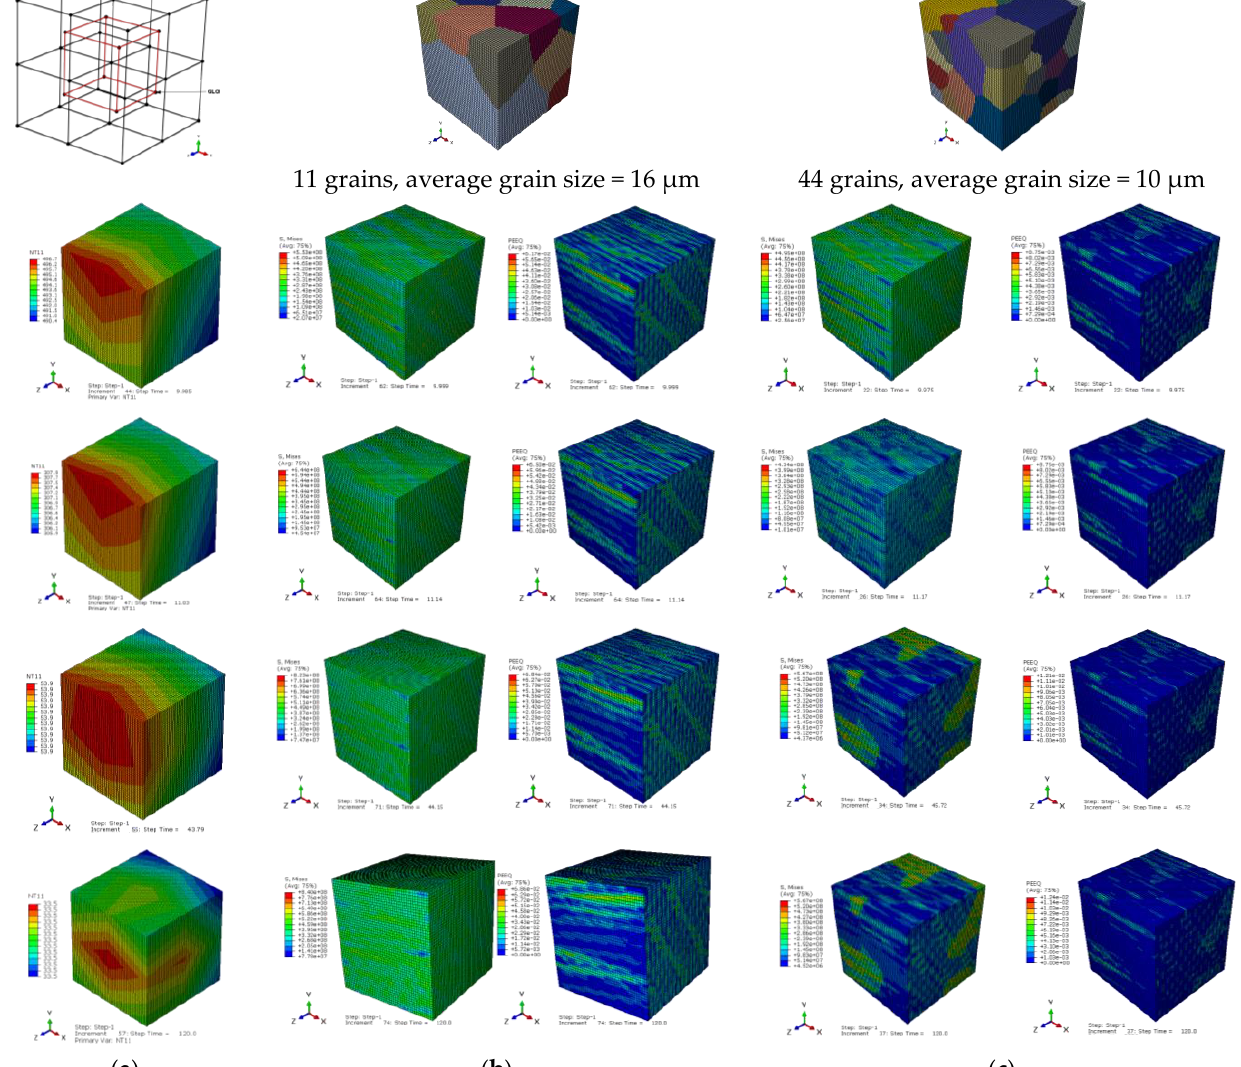
Figure 4. Temperature, stress, and strain distributions in representative volume elements (RVEs) at documented step times; ( a ) thermal gradient contours ( b ) micro residual stresses and equivalent plastic strains in the 11 grains aggregate; ( c ) micro residual stresses and equivalent plastic strains in the 44 grains aggregate. The units of Mises residual stresses are in Pascal.